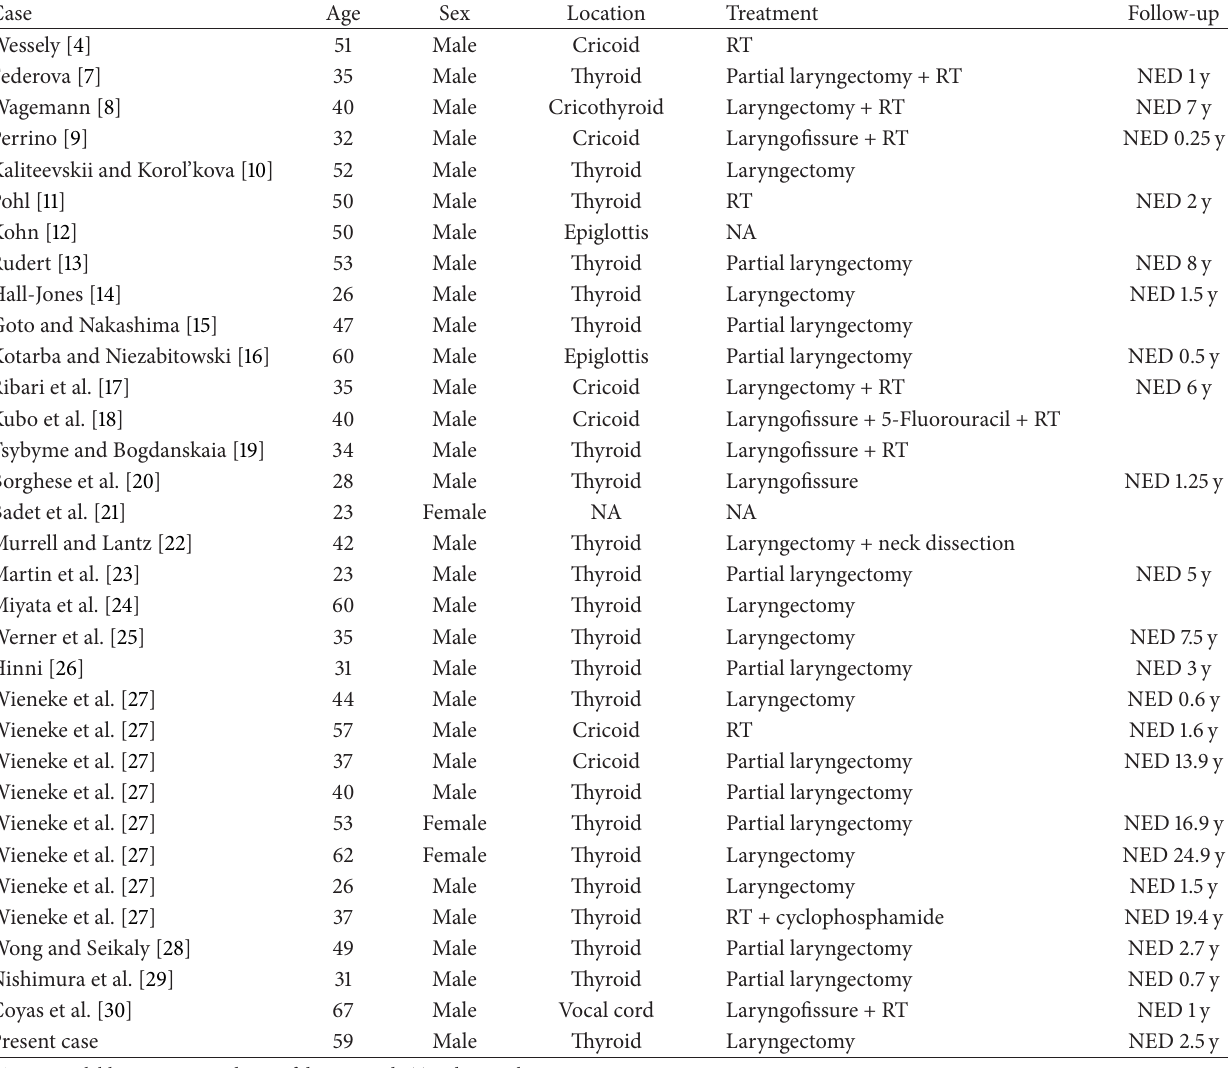
Table 1: Summary of reported cases of GCT of the larynx.